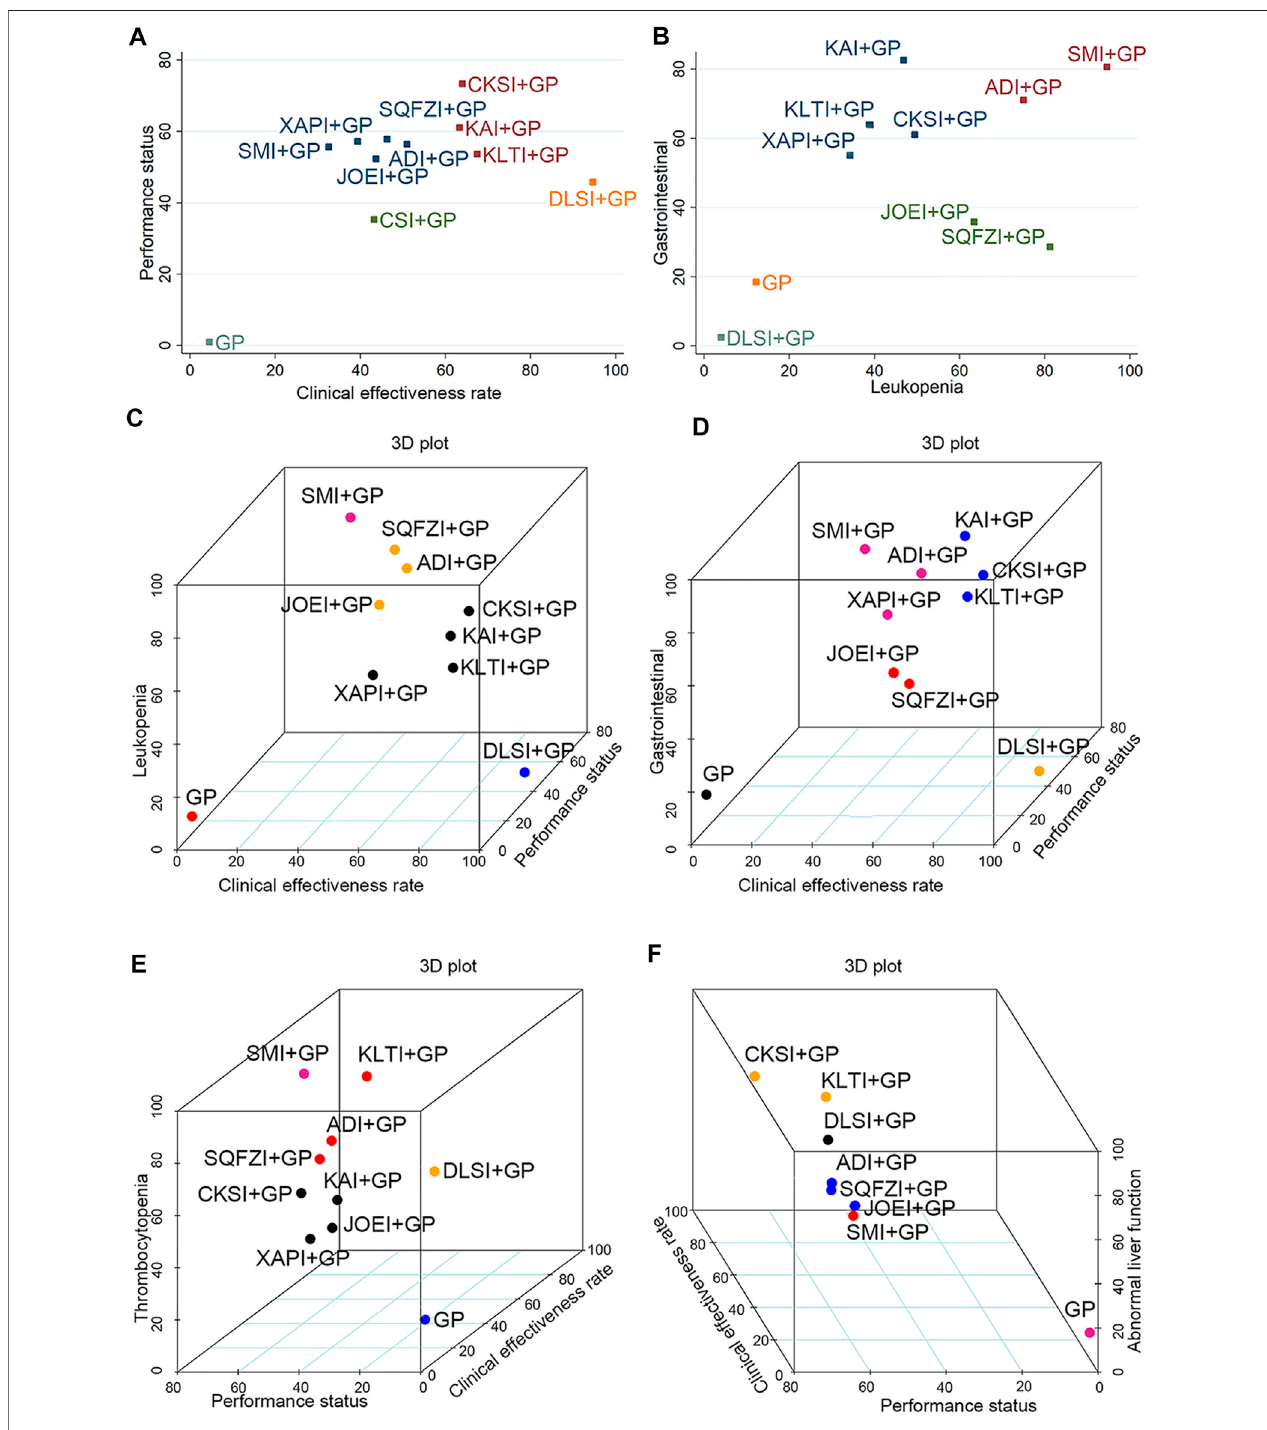
FIGURE 6 | Cluster analysis plots for six outcomes. (A) Clinical effectiveness rate (x-axis) and performance status (y-axis); (B) Leukopenia (x-axis) and gastrointestinal reactions (y-axis); (C) Clinical effectiveness rate (x-axis), performance status (y-axis), and leukopenia (z-axis); (D) Clinical effectiveness rate (x-axis), performance status (y-axis), and gastrointestinal reactions (z-axis); (E) Performance status (x-axis), clinical effectiveness rate (y-axis), and thrombocytopenia (z-axis); (F) Performance status (x-axis), clinical effectiveness rate (y-axis), and abnormal liver function (z-axis). Note: Interventions with the same color belong to the same cluster, and interventions located in the upper-right corner indicate optimal therapy for two different outcomes. ADI, Aidi injection; CKSI, Compound Kushen injection; DLSI, Delisheng injection; GP, Gemcitabine plus Cisplatin; JOEI, Javanica oil emulsion injection; KAI, Kangai injection; KLTI, Kanglaite injection; SMI, Shenmai injection; SQFZI, Shenqifuzheng injection; and XAPI, Xiaoaiping injection.